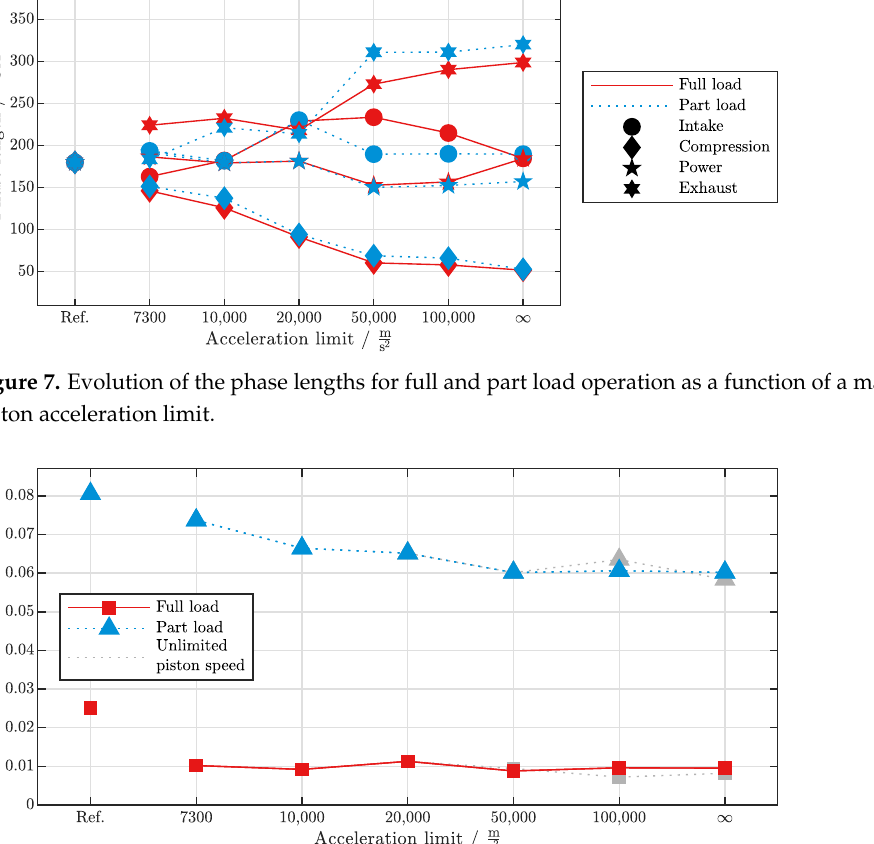
Figure 8. Evolution of the normalized pumping losses for full and part load operation as a function of the maximum piston acceleration limit.